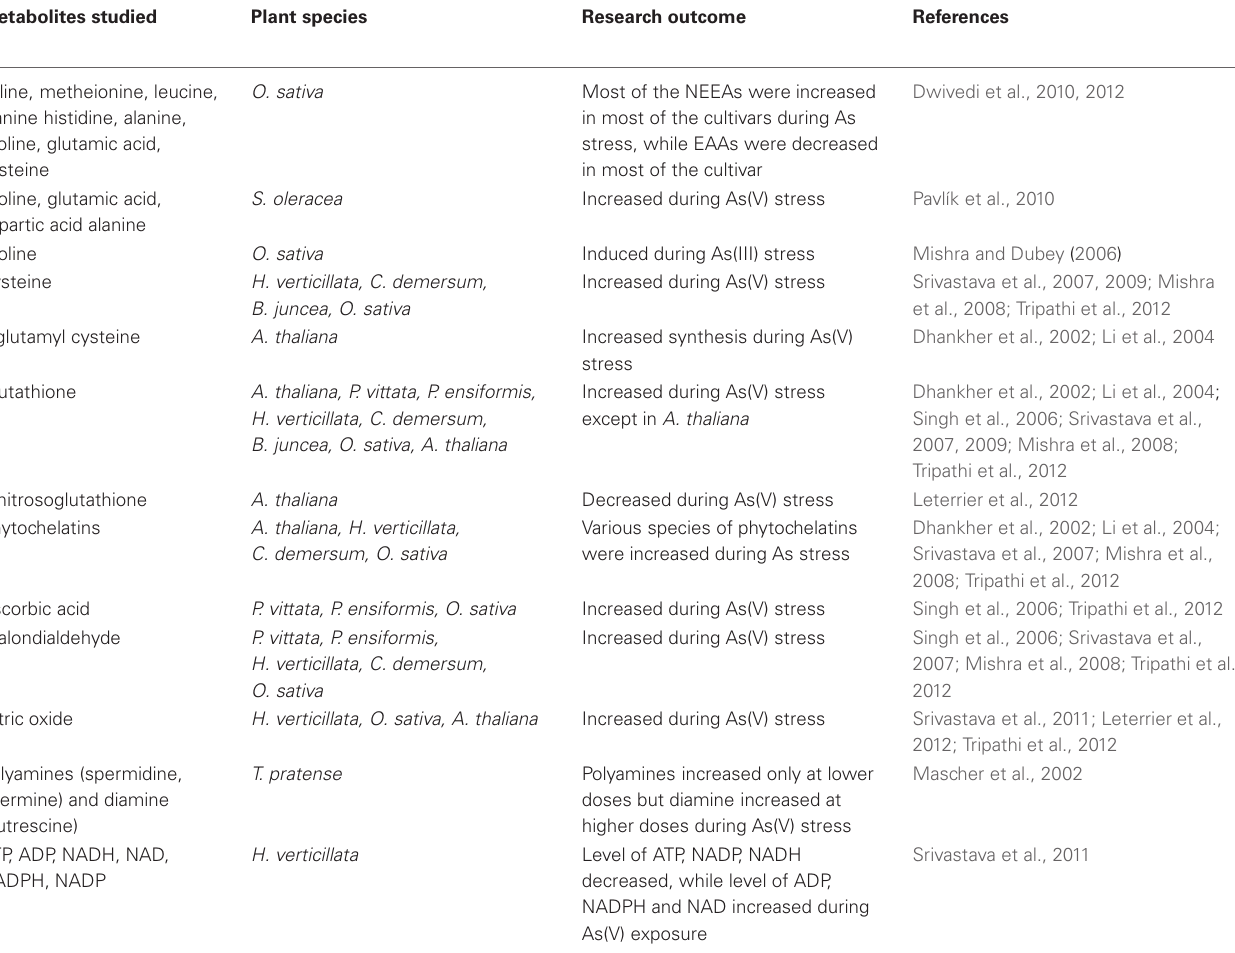
Table 3 | Metabolites in different plant species during arsenic stress. Metabolites